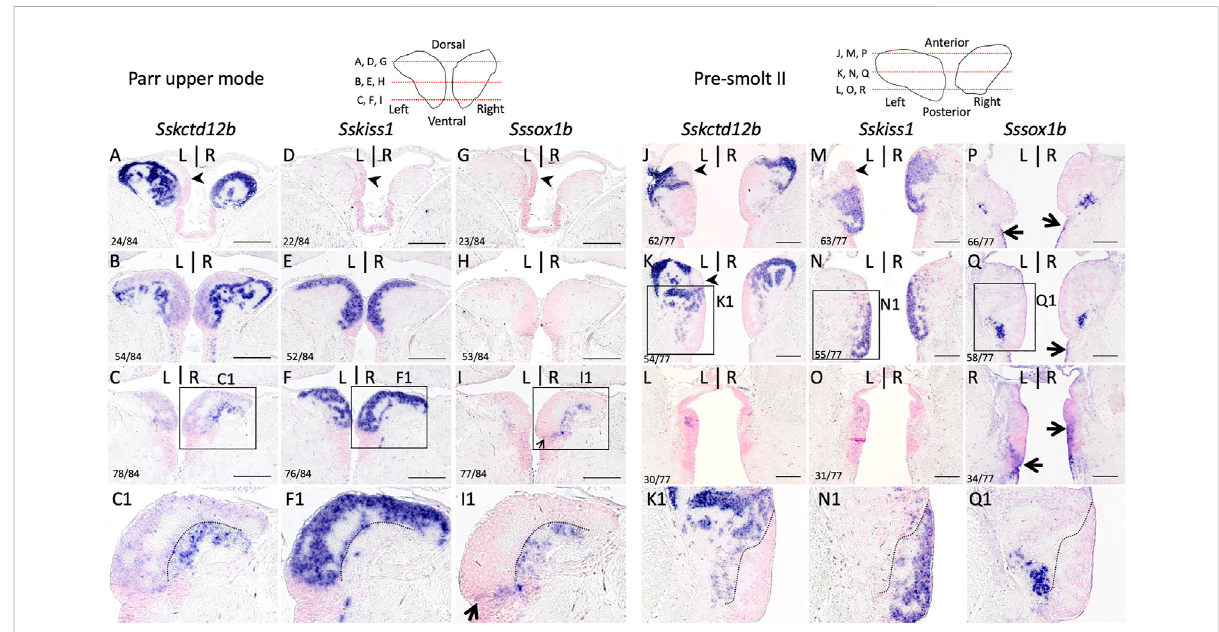
FIGURE 2 Subdomain organization of habenulae in Atlantic salmon during smolti fi cation. (A – R) respectively show sections of parr upper mode and pre- smolt II specimens following ISH with probes for Sskctd12b (A – C,J – L) , Sskiss1 (D – F,M – O) and SsSox1b (G – I,P – R) . (A – I) are horizontal sections, (J – R) transverse sections. Schemes in the upper line show the levels of the sections along the dorso-ventral (A – I) or antero-posterior (J – Q) axis as indicated. The numbers of the sections shown along these axes are also indicated in the bottom left corner of the photographs. (C1,F1,I1) and (K1,N1,Q1) show higher magni fi cations of the areas boxed in (C,F,I) and (K,N,Q) . Dotted lines in (F1) and (N1) and in adjacent sections (C1,I1) and (K1,Q1) delineate the posterior (F1) and dorsal (N1) limits of Sskiss1 territory, which largely exclude Sskctd12b and Sssox1b signals. Black arrowheads in (A,J,K) point towards a left dorsal territory negative for SsKctd12b and expressing pax6 (see below). Scale bars = 200